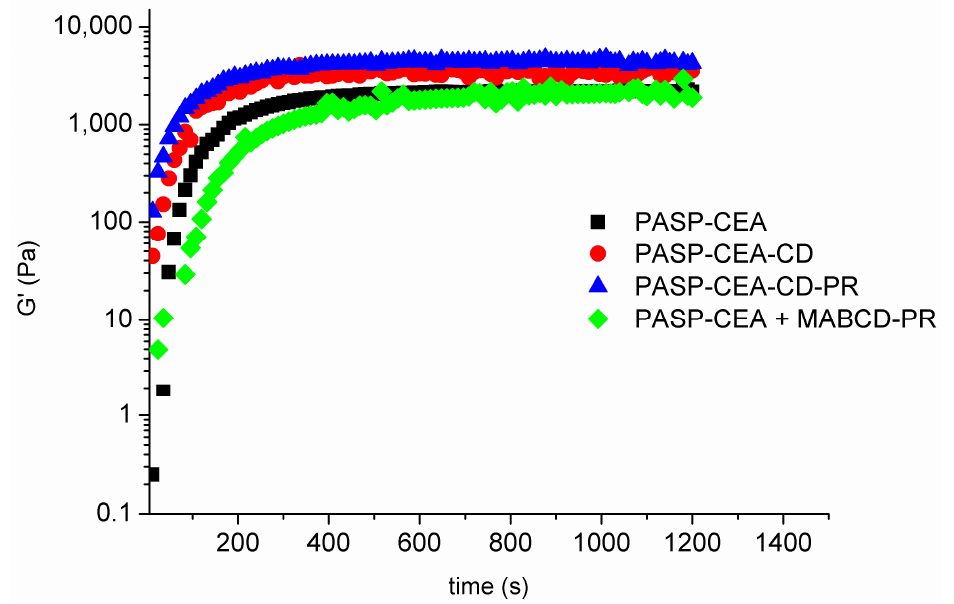
Figure 4. Gelation of the different polymer solutions.